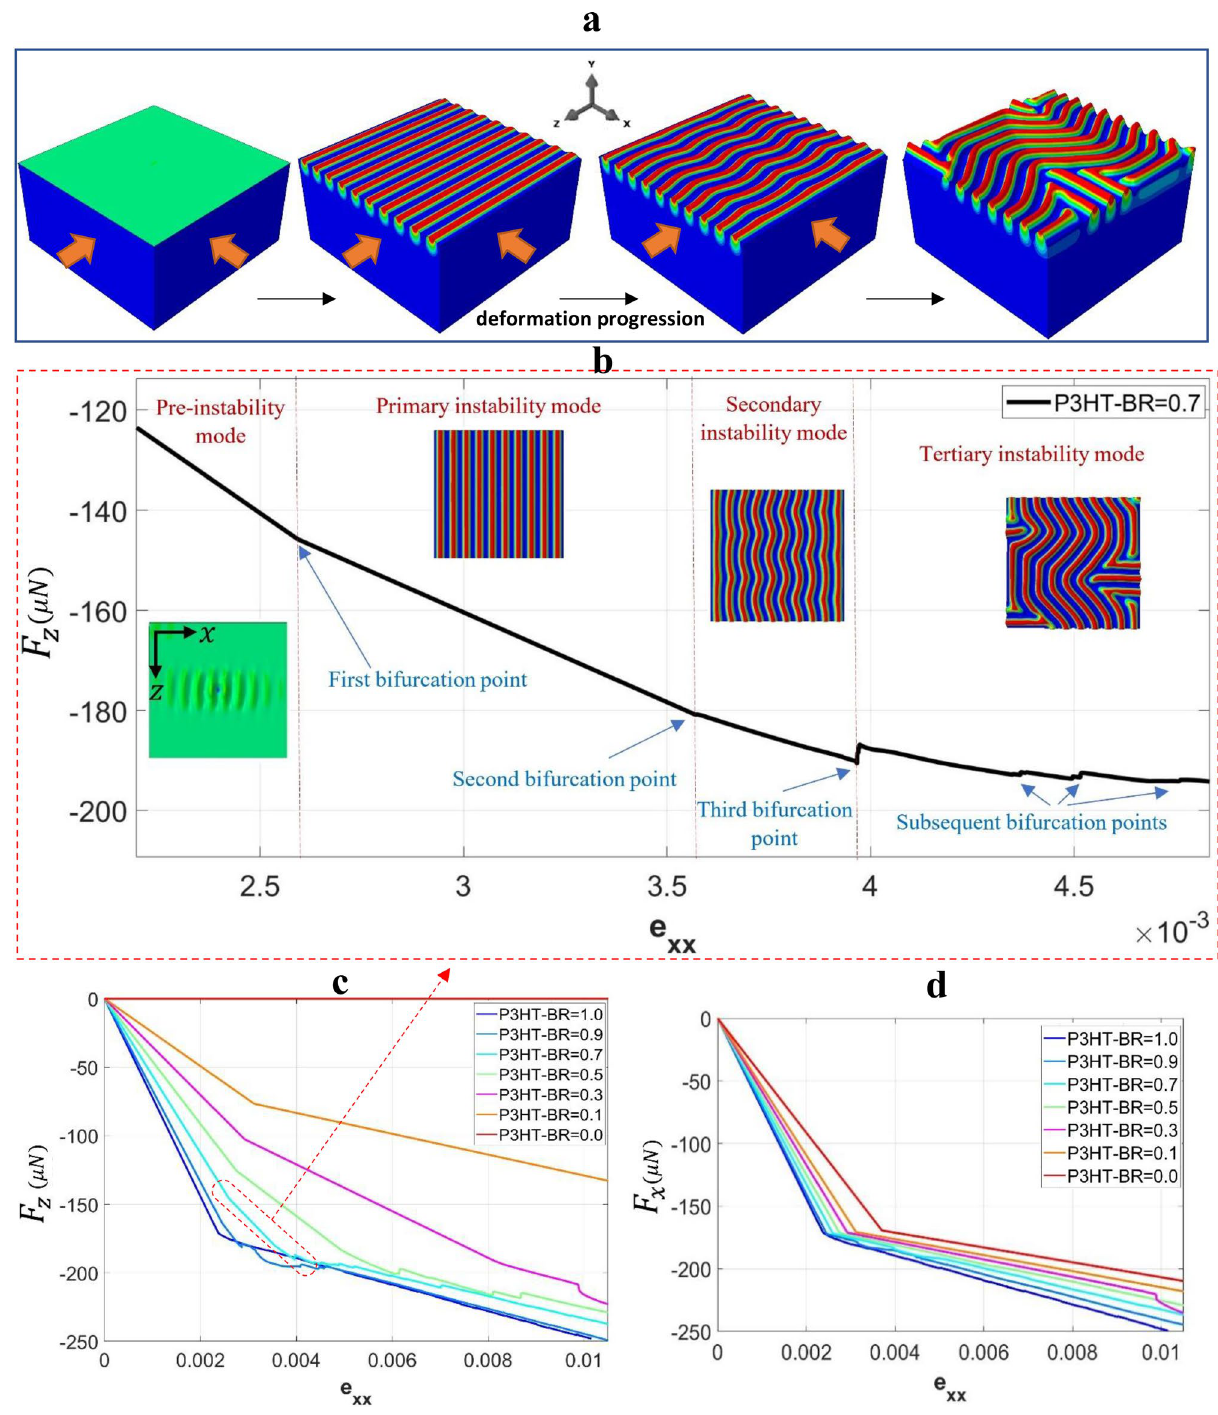
Figure 4. ( a , b ) Evolution of surface wrinkling patterns during the loading history, starting from a flat surface to 1D mode (primary), herringbone (secondary), and then to labyrinth (tertiary) mode, obtained from a single simulation run for the case of non-equi-biaxial loading with BR = 0.7. ( c , d ) Variation of reaction force ( c ) F z and ( d ) F x with the applied strain ( e xx ); the results for various BR values are included for Wrinkle patterns vs. macroscopic response. The present work investigates the full range of biaxial loading between BR = 0 and 1. In this section we first present the simulated surface morphologies and their correlation with the macroscopic load response, using a special case of non-equi-biaxial loading with BR = 0.7. While the case of BR = 0.7 was chosen arbitrarily, this loading ratio does lead to a series of pattern changes from 1D mode (primary) to herringbone (secondary) and then to labyrinth (tertiary), as shown in Fig. 4a. The entire sequence from the pre-instability stage can be directly captured in one simulation run. From the model